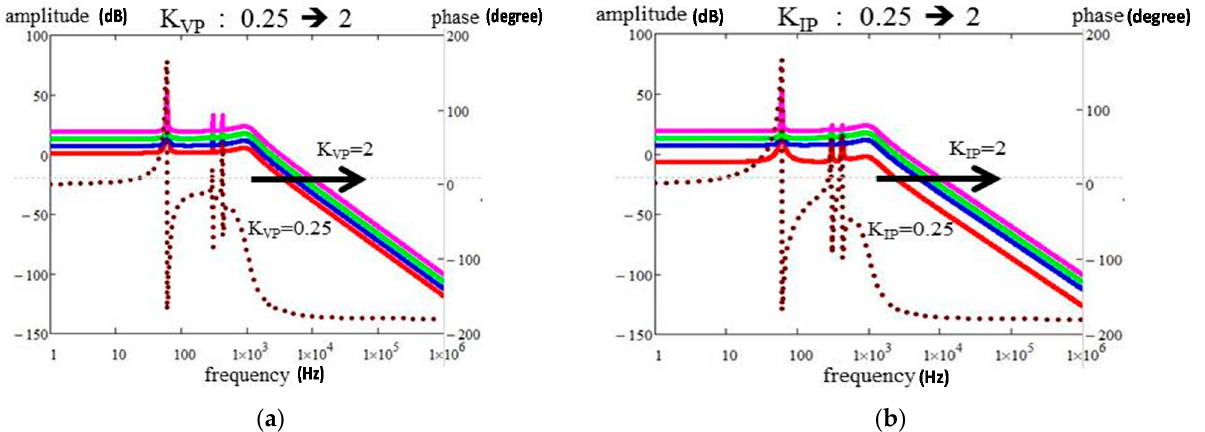
Figure 14. Variation of the proportional coefficient of the PR controller ( a ) Voltage resonant controller ( b ) Current resonant controller.